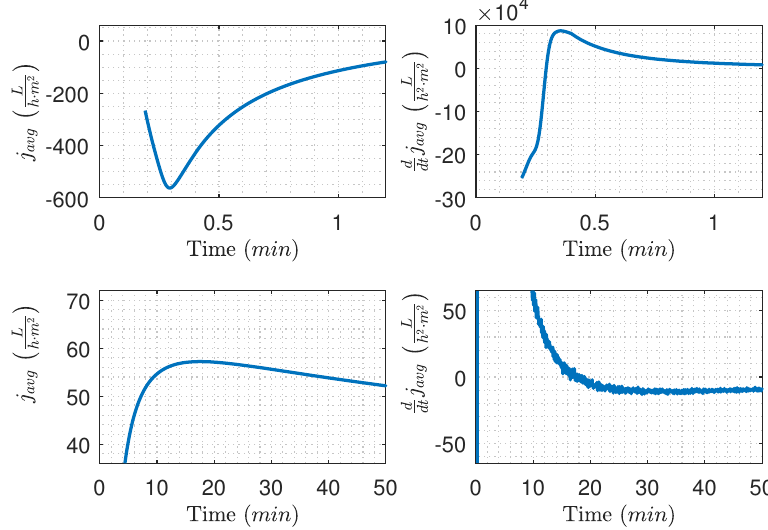
Figure 12. Estimated j avg and its derivative, where the top figures show the effect of filter initialization and the transition between backwashing and filtration on j avg and d j avg for the entire experiment—based on data from Figure 11. values of j avg and d dt